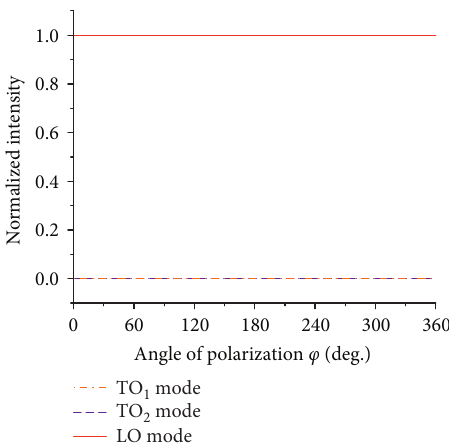
Figure 4: Raman intensity distribution of vertical backscattering without an analyzer.